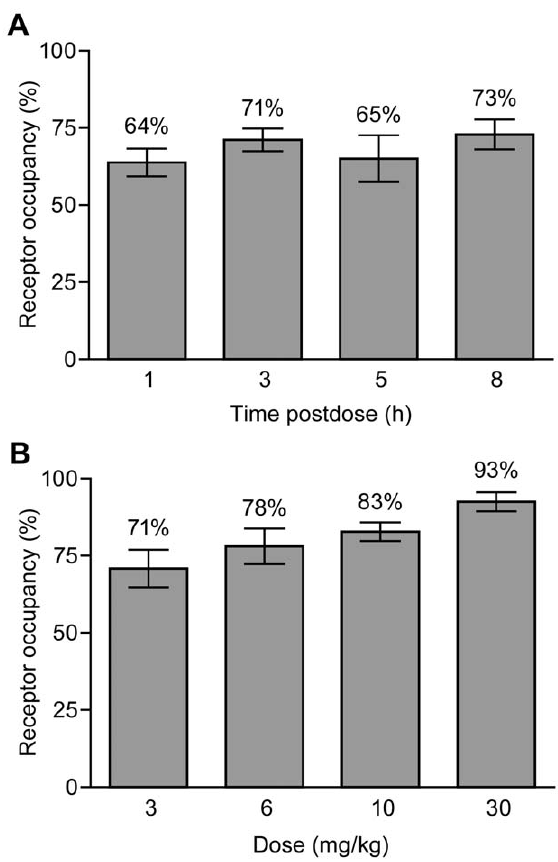
Figure 2. Invivo inhibition of hepatic 125 I-glucagon binding in the hGCGR mouse following (A) acute and (B) chronic dosing with GRA1. The data are mean ( 6 SEM) percent reductions in liver 125 I- glucagon content measured (A) 1, 3, 5, and 8 h after a single oral dose of 3 mg/kg GRA1, and (B) after treatment for 30 days with control diet or food/drug admixtures that provided 3, 6, 10, or 30 mg/kg ? day GRA1. Pharmacokinetic analysis performed during the experiment in (A) determined that mean plasma GRA1 concentrations were 0.5, 0.6, 0.5, and 0.7 m M at 1, 3, 5, and 8 h postdose, respectively.